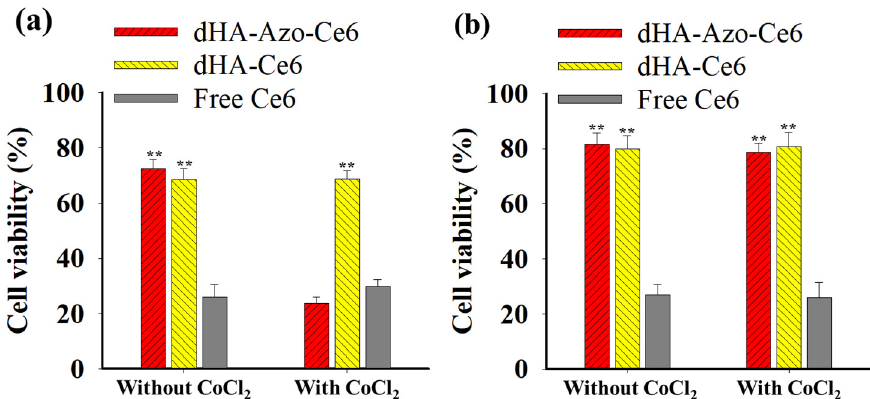
Figure 6. Phototoxicities determined by CCK-8 assay of ( a ) HeLa and ( b ) NIH3T3 cells treated with each sample (equivalent Ce6 10 µ g/mL) and free Ce6 (10 µ g/mL) under environment with CoCl 2 or without CoCl 2 for 2 h with light irradiation (for 10 min at light intensity of 5.2 mW/cm 2 using a 670 nm laser source) (n = 7, as multiple experiments, ** p < 0.01 compared to free Ce6).